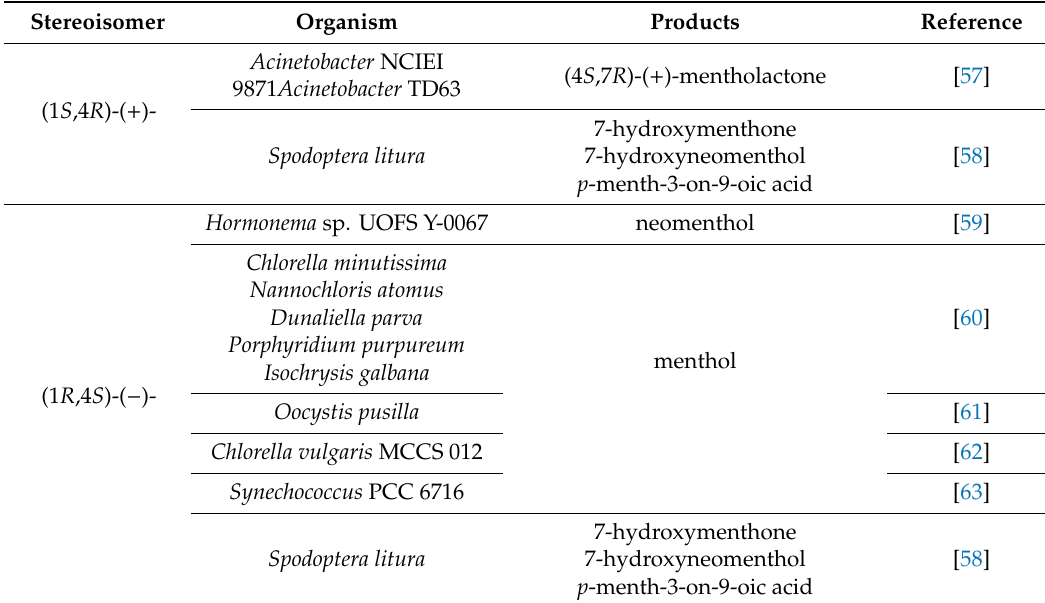
Table 7. Biotransformation of menthone.